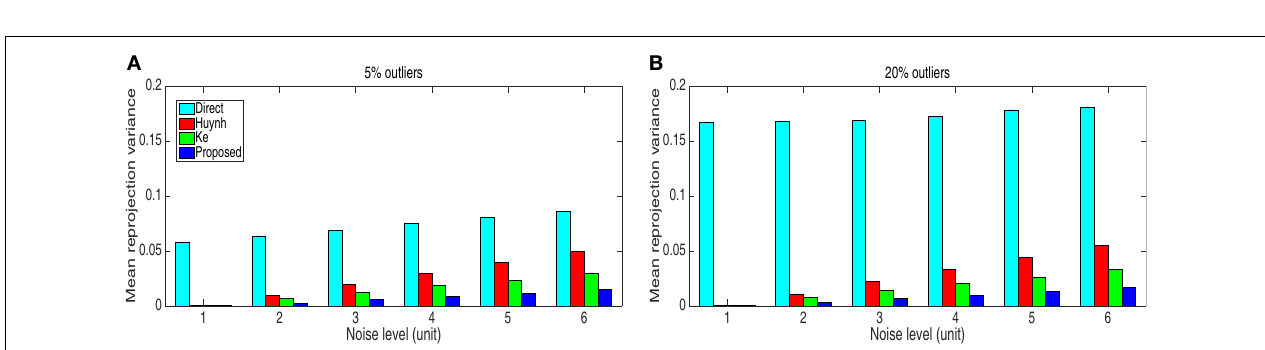
FIGURE 4 | The mean reprojection variance of different algorithms with respect to different noise levels and outliers . (A) 5% outliers, (B) 20% outliers.